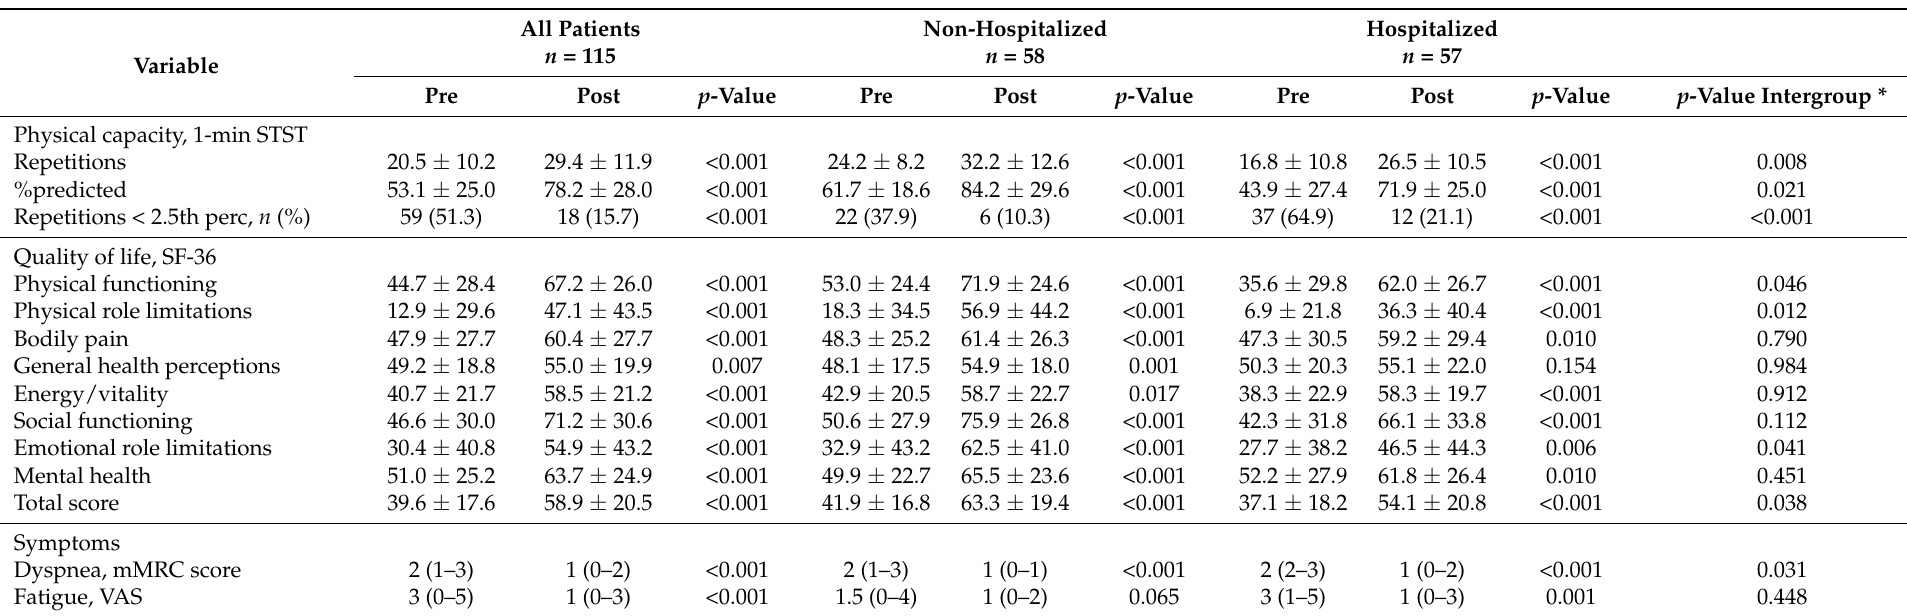
Table 2. Outcome measures results by